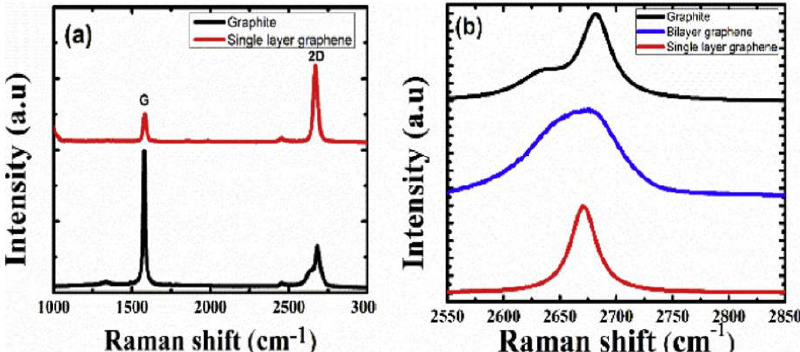
Figure 12. ( a ) Raman spectra for graphite and single-layer graphene and ( b ) 2D band enlarged. Reprinted with permission from Ref. [66]. 2020, Elsevier.